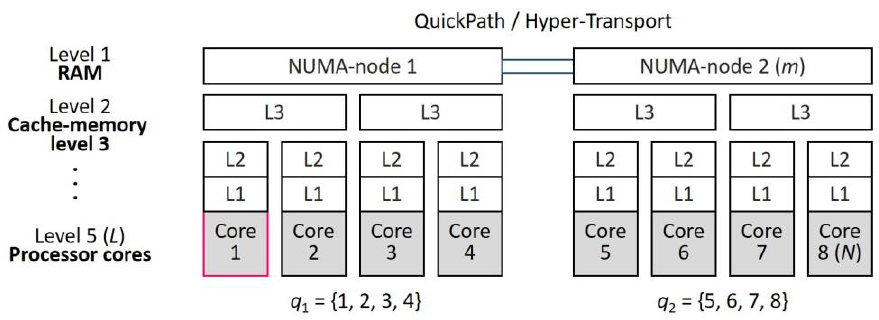
Figure 2. An example of the hierarchical structure of a multi-core CS, N = 8, L = 5, m = 2, c 23 = 2, p (3; 4) = 2, m = 2, m (3) = 1.